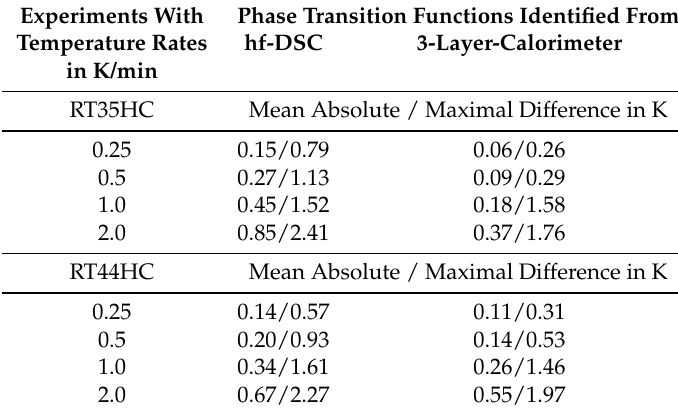
Table 2. Mean absolute and maximal differences between experimentally measured and predicted PCM temperatures in the HEX. Differences are calculated from the data shown in Figure